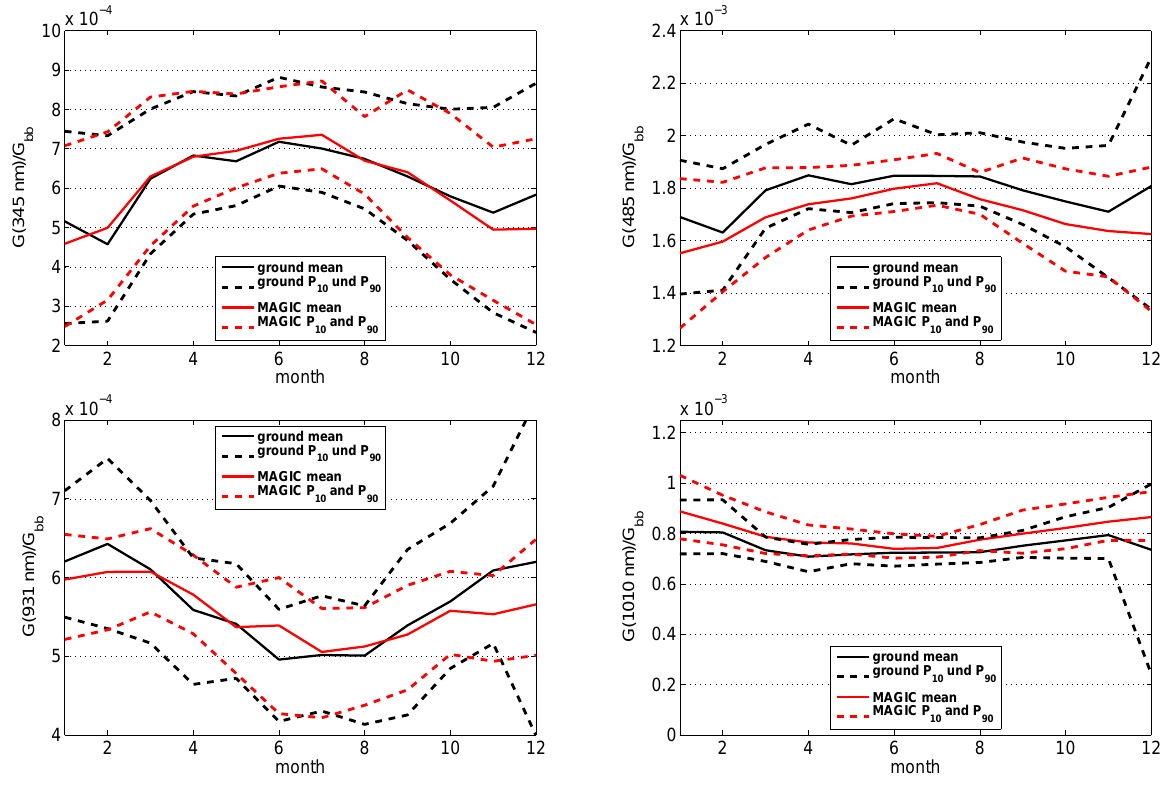
Figure 11. Annual course of normalized irradiance for four wavelength bands for Stuttgart. Comparison of measured data and SPECMAGIC